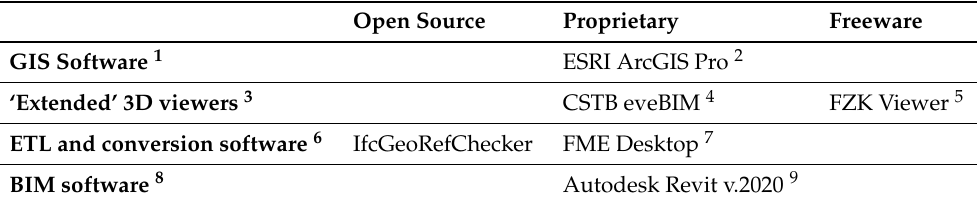
Table 5. Software tested for IFC georeferencing (Task